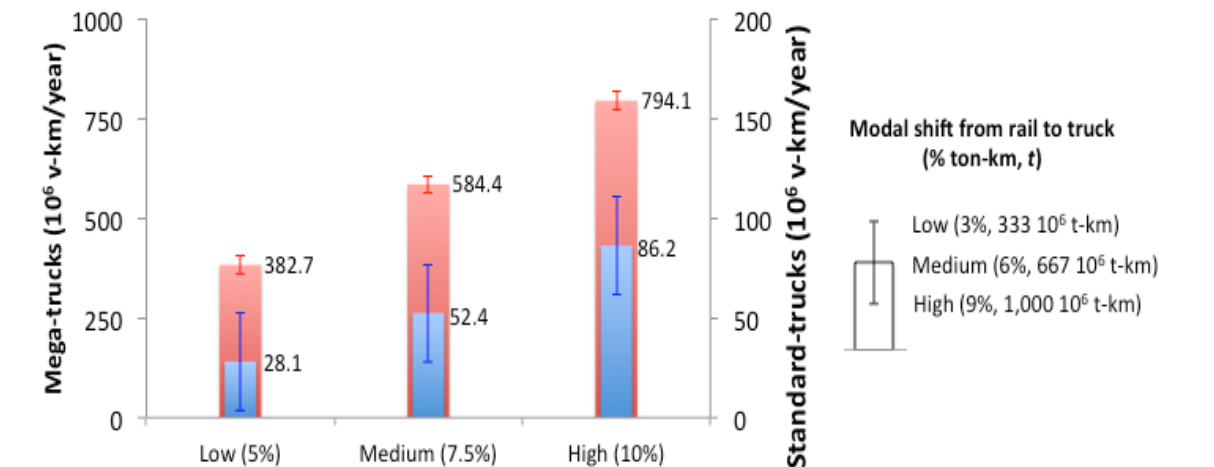
Figure 3. Estimates of vehicle kilometre reductions, resulting from the increase in the maximum allowable gross weight of trucks (in million v-km per year), by loading and modal